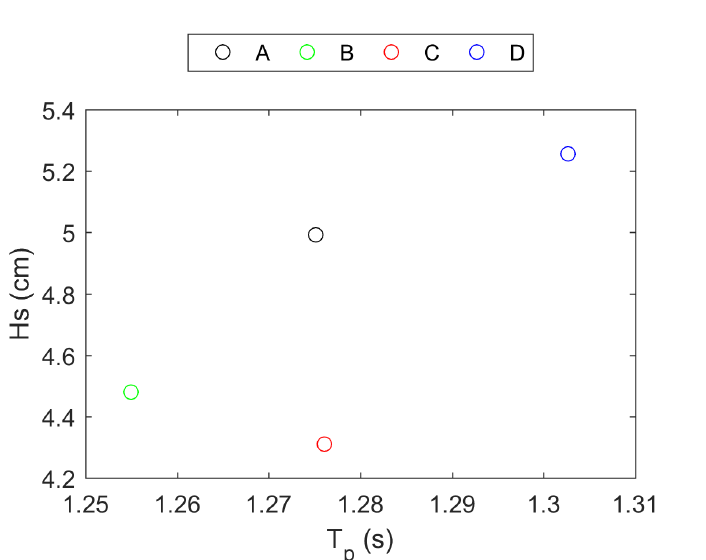
Figure 4. Realised H s as function of realised T p for targeted JONSWAP T p = 1.29 s and H s = 5 cm sea-state.